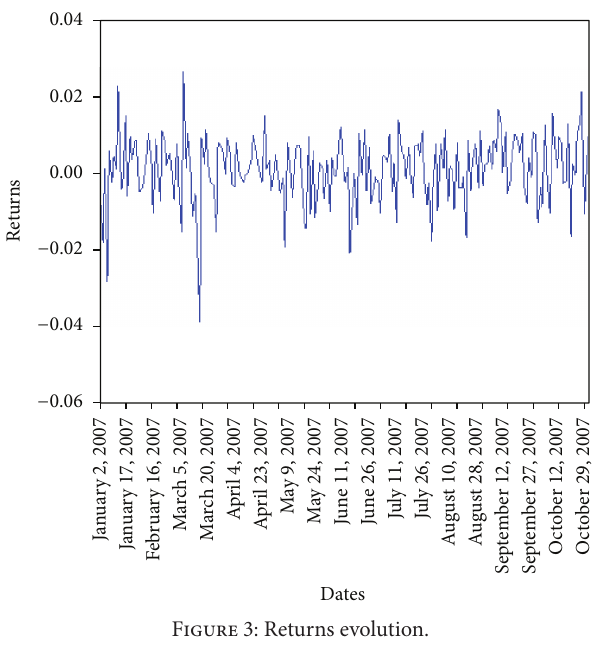
Figure 3: Returns evolution.